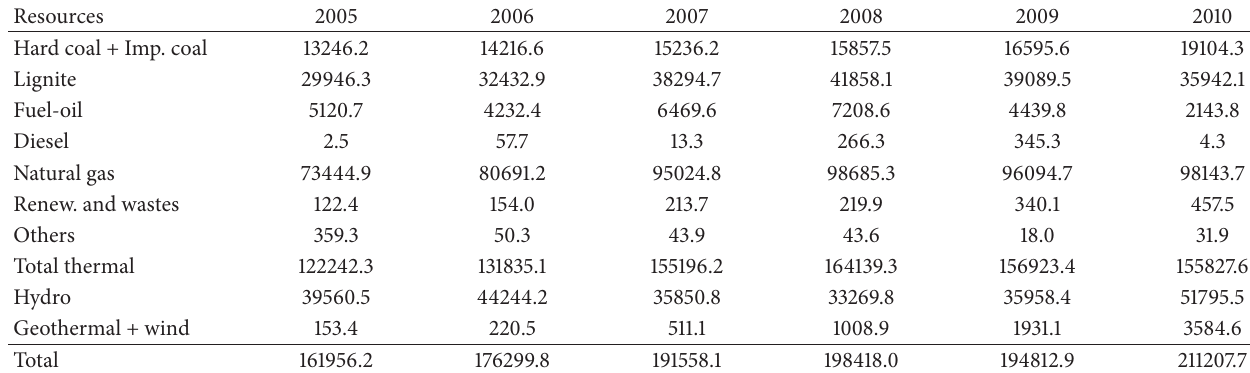
Table 1: Distribution of resources of the Turkey’s gross electrical energy production (GWh).